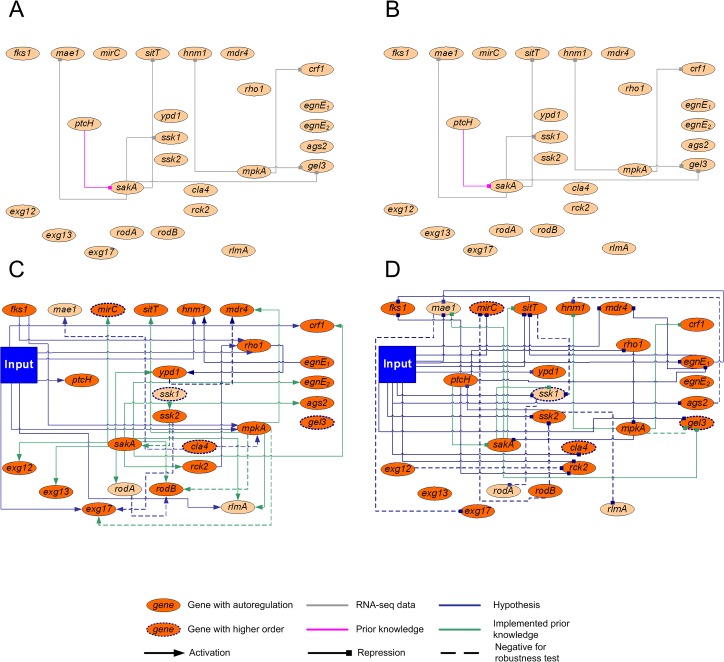
NetGenerator used for modeling prediction.(A) Collected prior-knowledge interactions with activating effects. (B) Collected prior-knowledge interactions with inhibiting effects. (C) Activating and (D) inhibiting interactions of the final predicted network. The legend is shown below the figure. Input marks caspofungin induction. Information about the selected genes is reported in Table 1.